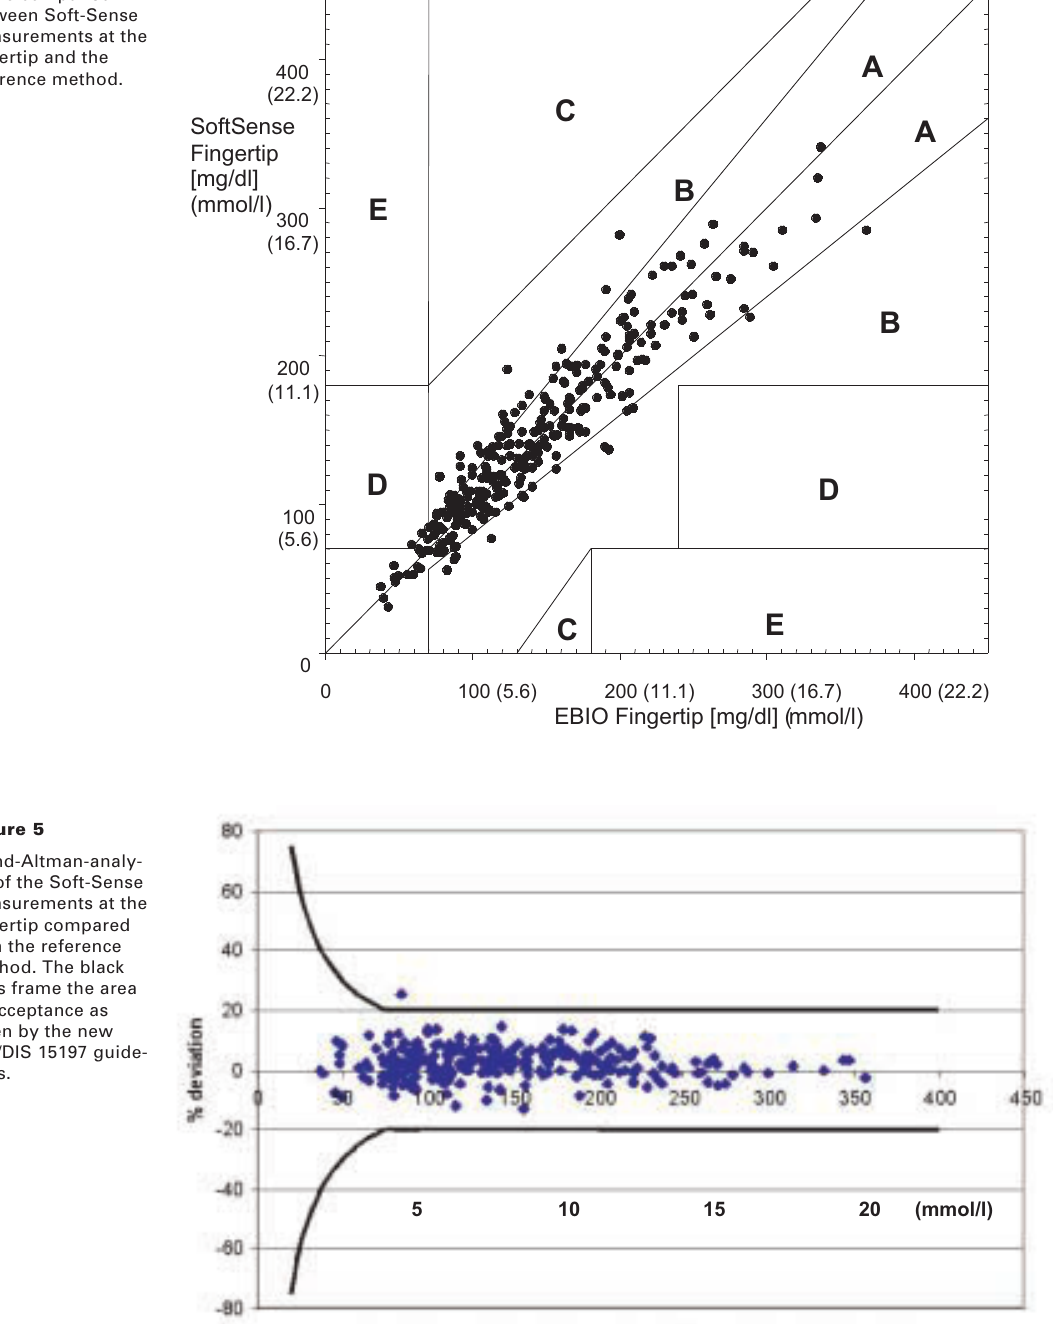
Error grid analysis of the comparison between Soft-Sense measurements at the fingertip and the reference